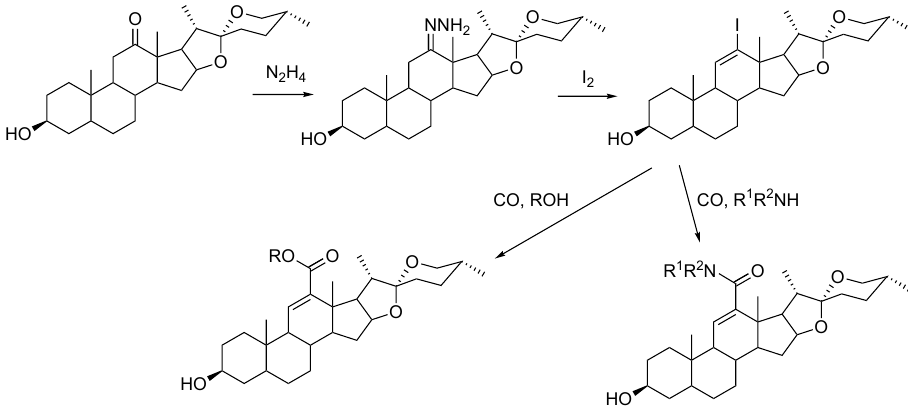
Figure 16. Synthesis of 12-carboxamido- and 12-carboxyl-11-spirostenes. 20-Carboxamidopregnene derivatives, such as 3 β -acetoxy-5 α -pregn-20-ene-20- carboxamides and 5 α -pregn-20-ene-20-carboxamides were synthesized from the corre- sponding iodoalkenes and various N -nucleophiles (Figure 17). The iodoalkenes